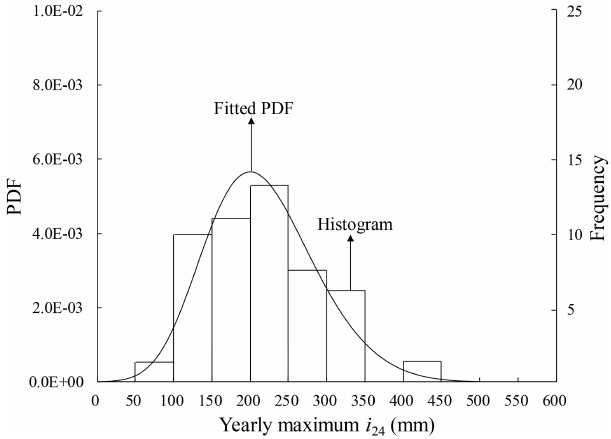
Figure 5. Histogram and fitted PDF of the yearly maximum i 24 in Hong